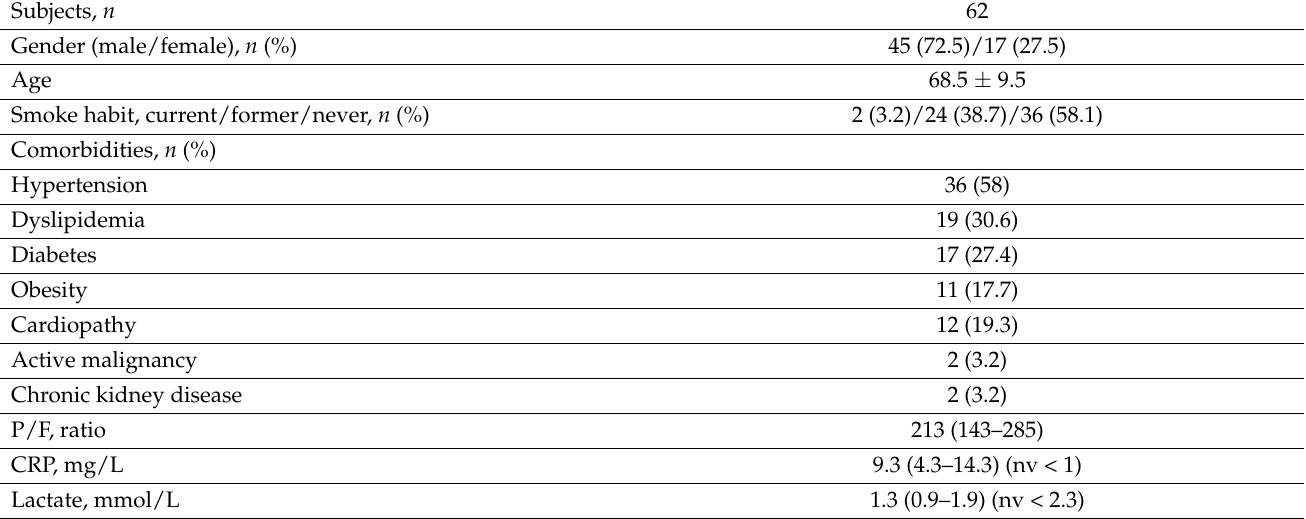
Table 1. Demographics, anamnestic data, laboratory tests, respiratory support and pharmacological treatment during